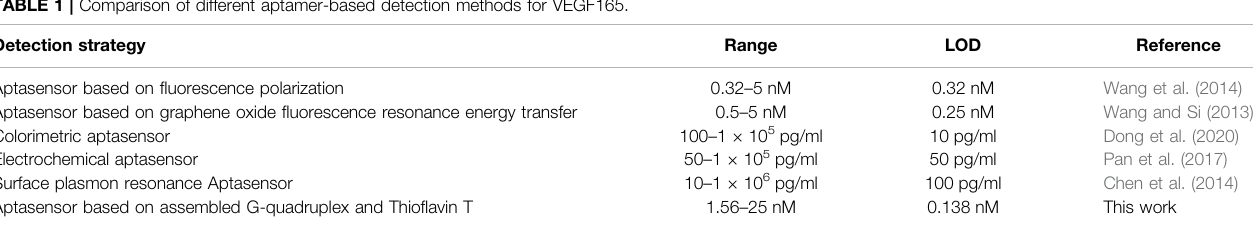
TABLE 1 | Comparison of different aptamer-based detection methods for VEGF165. Detection